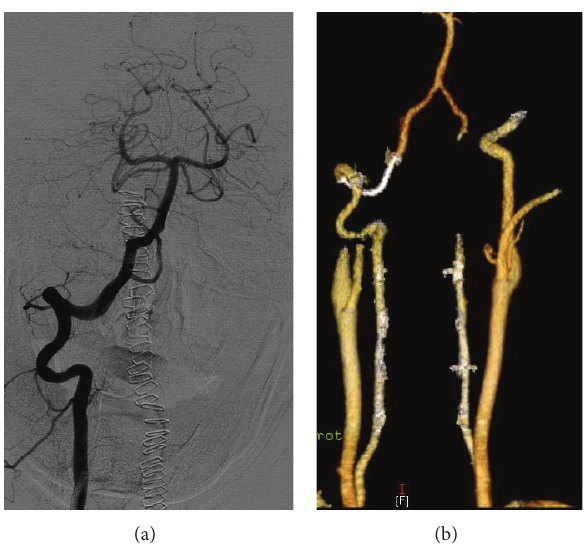
Figure 2: (a) shows right vertebral injection image immediately after deployment of the Pipeline Embolization Device. There is nonfilling of the pseudoaneurysm while the vertebral artery fills normally. (b) shows stable complete pseudoaneurysm occlusion and patent right vertebral artery in the CT angiogram performed at 10-month